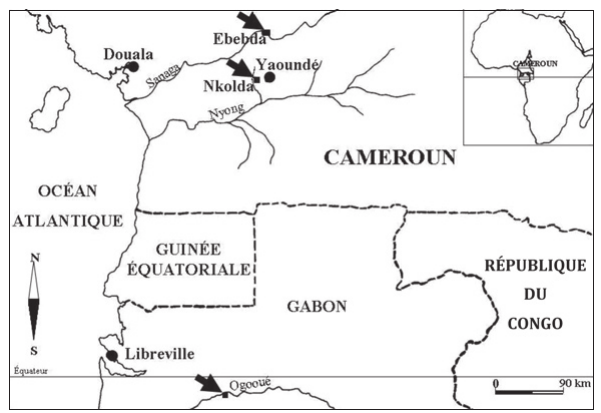
Figure 1. – Carte de la région d’Afrique Centrale montrant les trois localités où sont connues des populations de Metracoelophyinae. Les flèches indiquent les lieux précis des